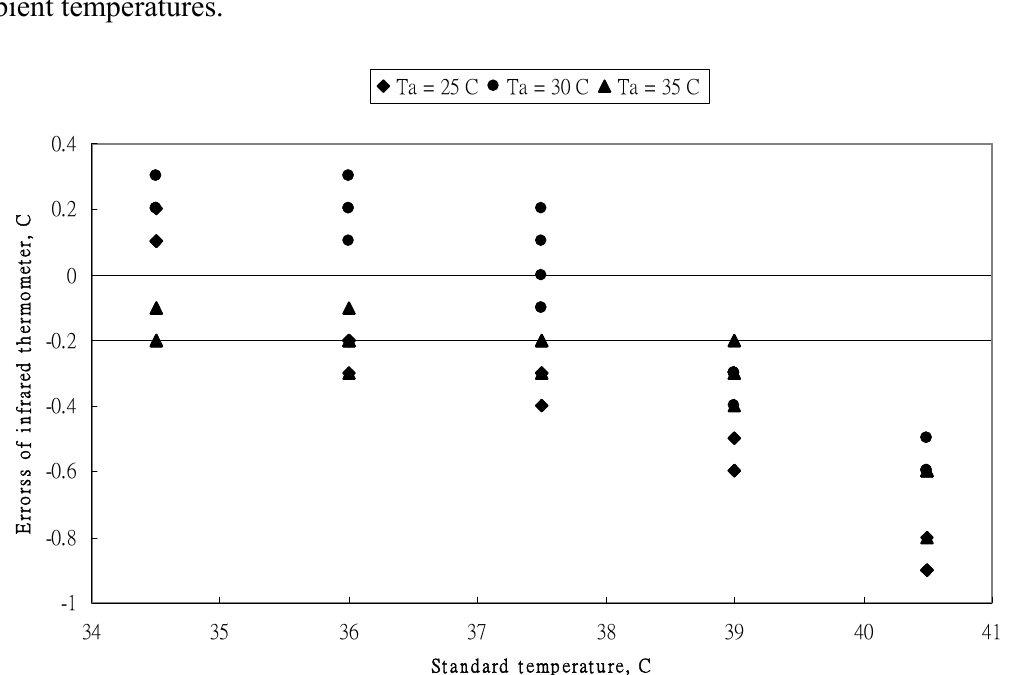
Figure 2. The error distribution of OMRON MC-510 thermometer at three ambient